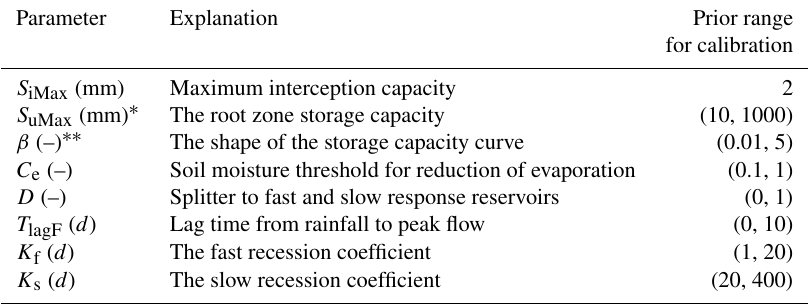
Table 1. The parameters of the models, and their prior ranges for calibration.